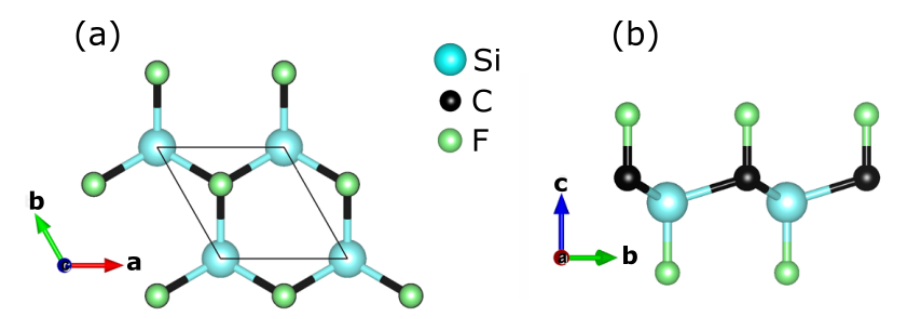
Figure 1. ( a ) The top and ( b ) the side views of CF 2 Si in its low-dimensional structure.